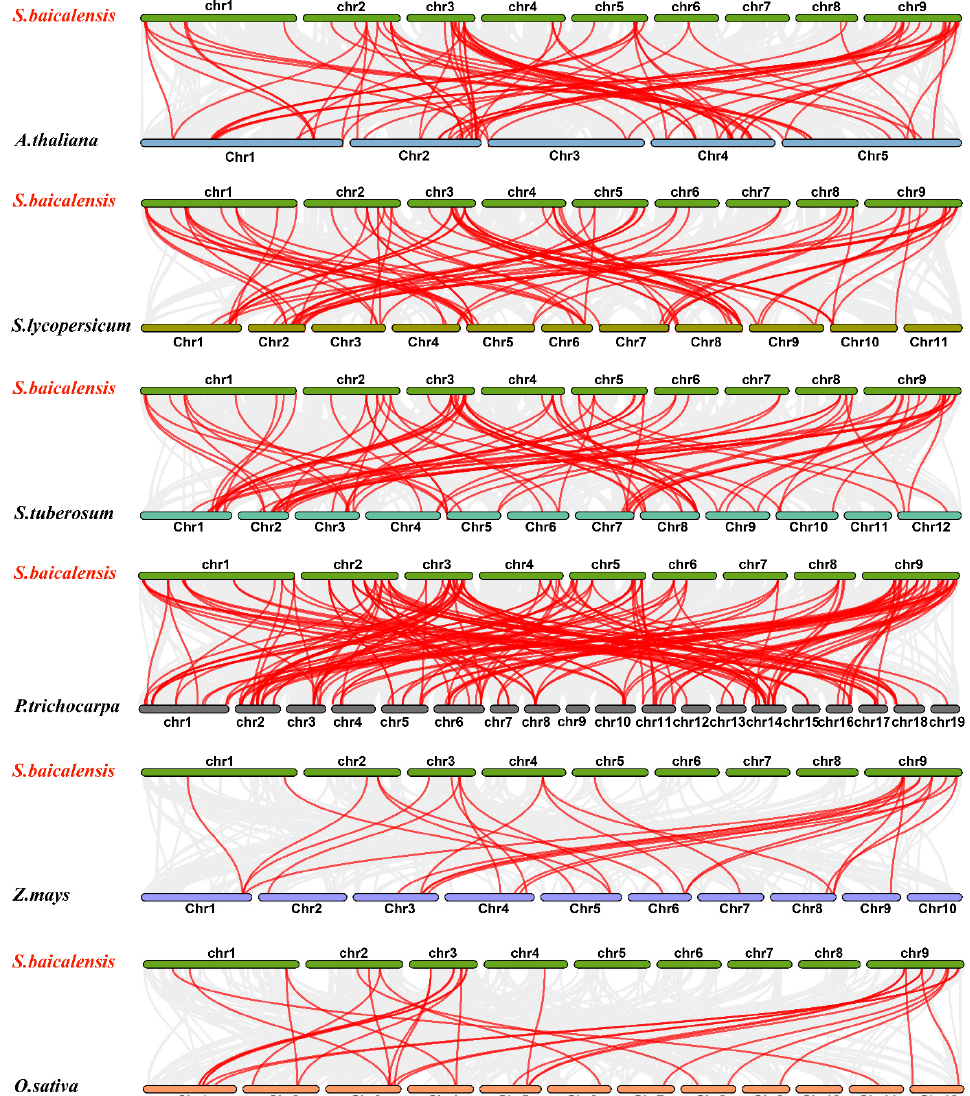
Figure 7. Synteny analysis of SbWRKY genes between and six plant species. The collinear blocks between S. baicalensis and other species were showed gray lines. The syntenic WRKY gene pairs between S. baicalensis and other species were highlighted in red. The chromosome number was in ‐ dicated at the top of each chromosome.